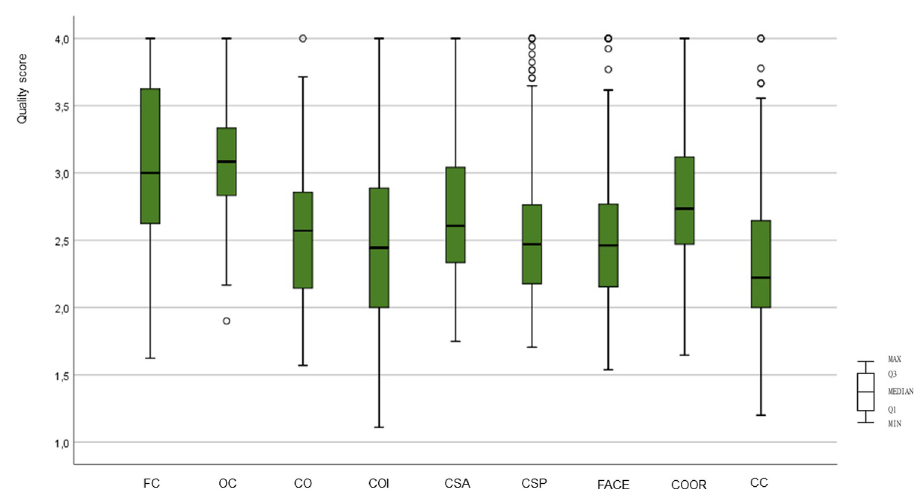
Fig 3. Primary care assessment from physicians’ perspectives (PCAT score) (N = 150). FC: First Contact; OC: Ongoing care; CO: Coordination; COI: Coordination (information system); CSA: Comprehensiveness (Services available); CSP: Comprehensiveness (Services provided); FACE: Family-Centeredness; COOR: Community Orientation; CC: Culturally Competent.